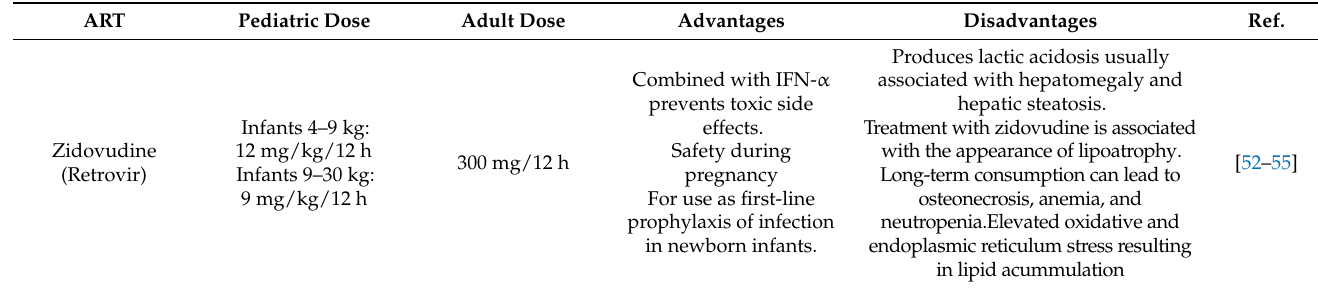
chain, interrupting its elongation and, as a consequence, viral replication [50,51]. Table 2. Nucleoside and nucleotide reverse transcriptase inhibitors